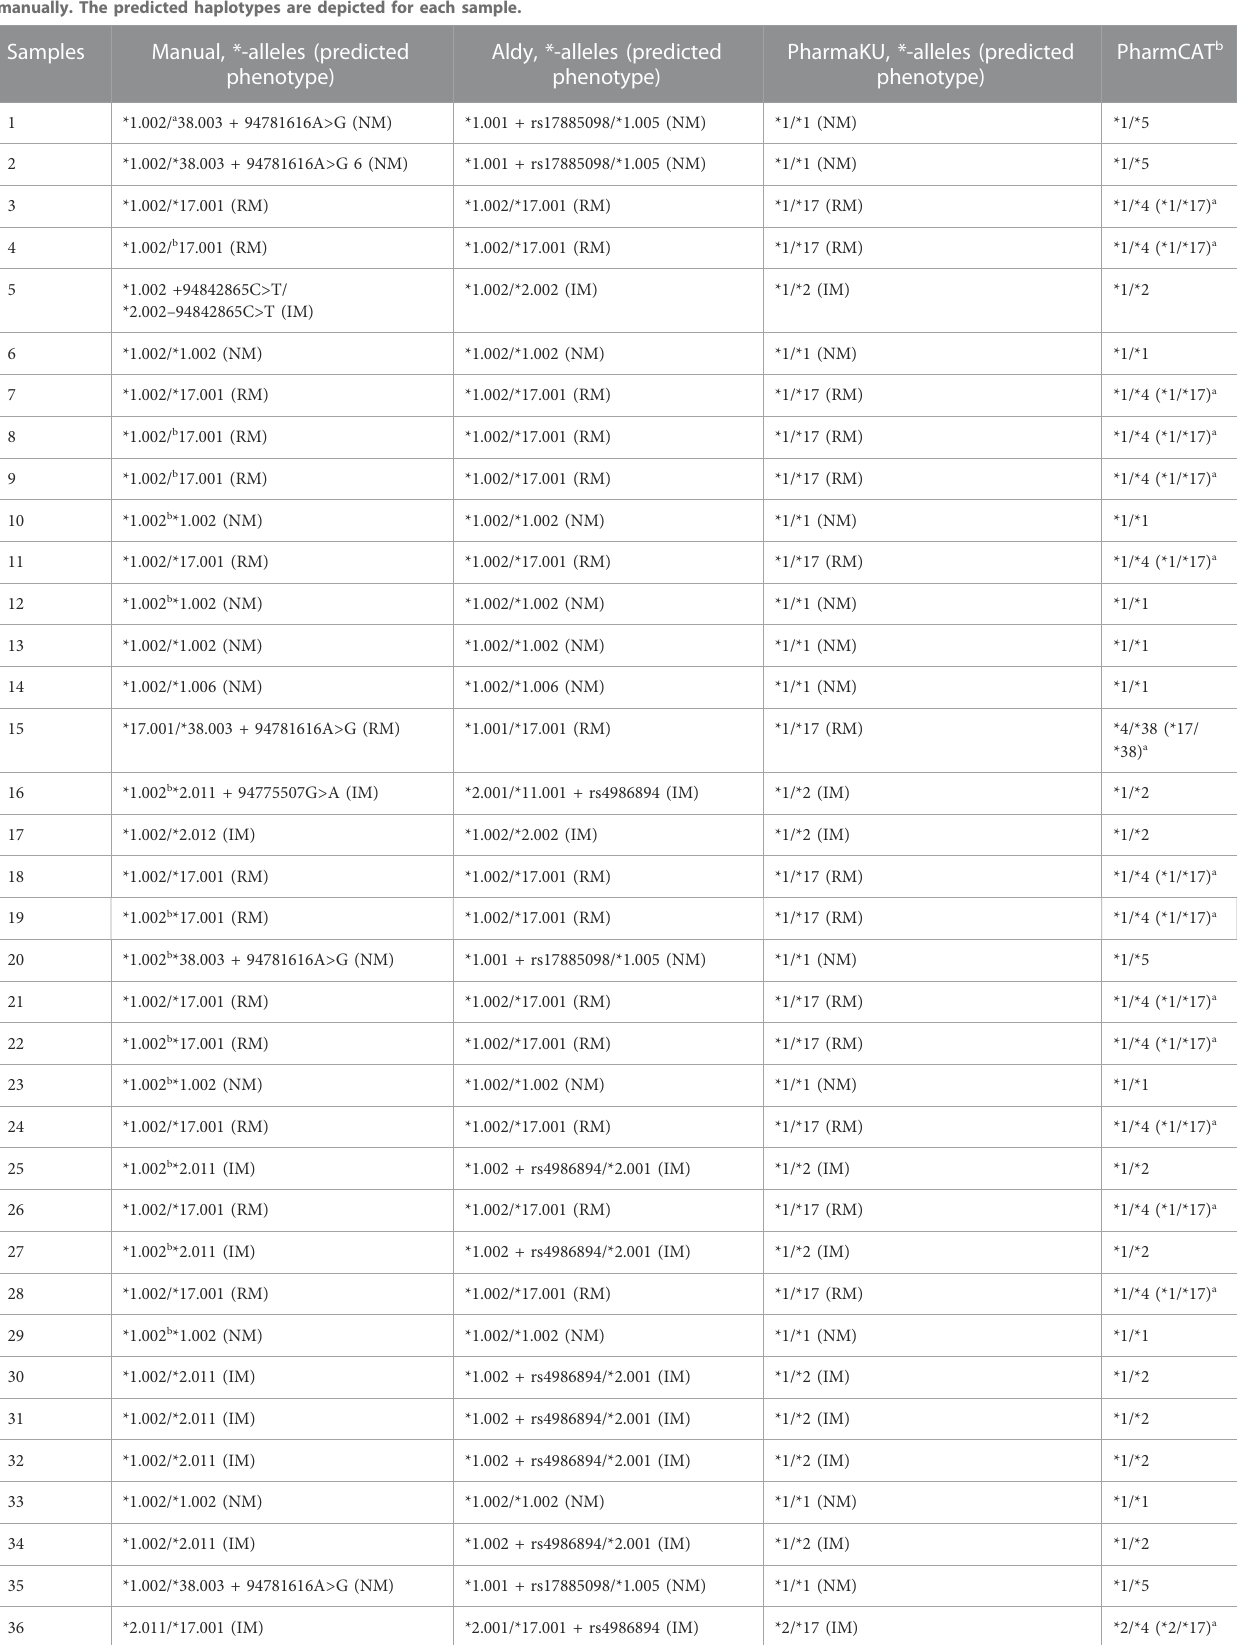
TABLE2Overviewofhaplotypeprediction bydifferent*-alleletools.The37samples wereassessedbydifferent*-alleletools(Aldy,PharmaKUandPharmCat) and manually. The predicted haplotypes are depicted for each